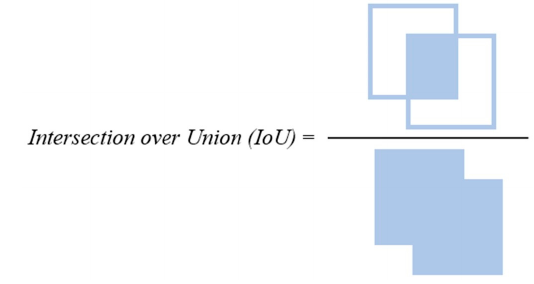
Figure 6. Computing the Intersection over Union.